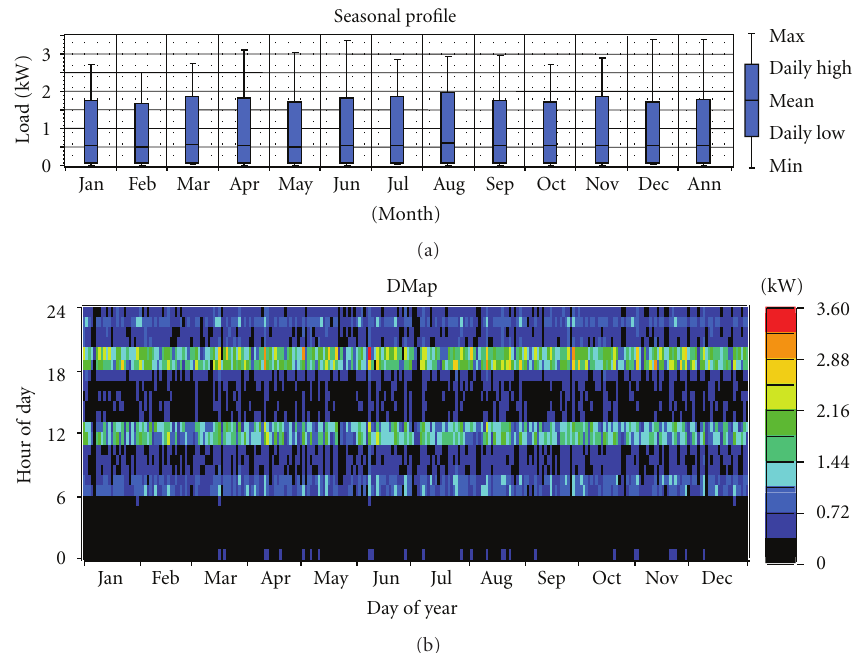
Figure 1: Average daily demand profile of the house considered in the